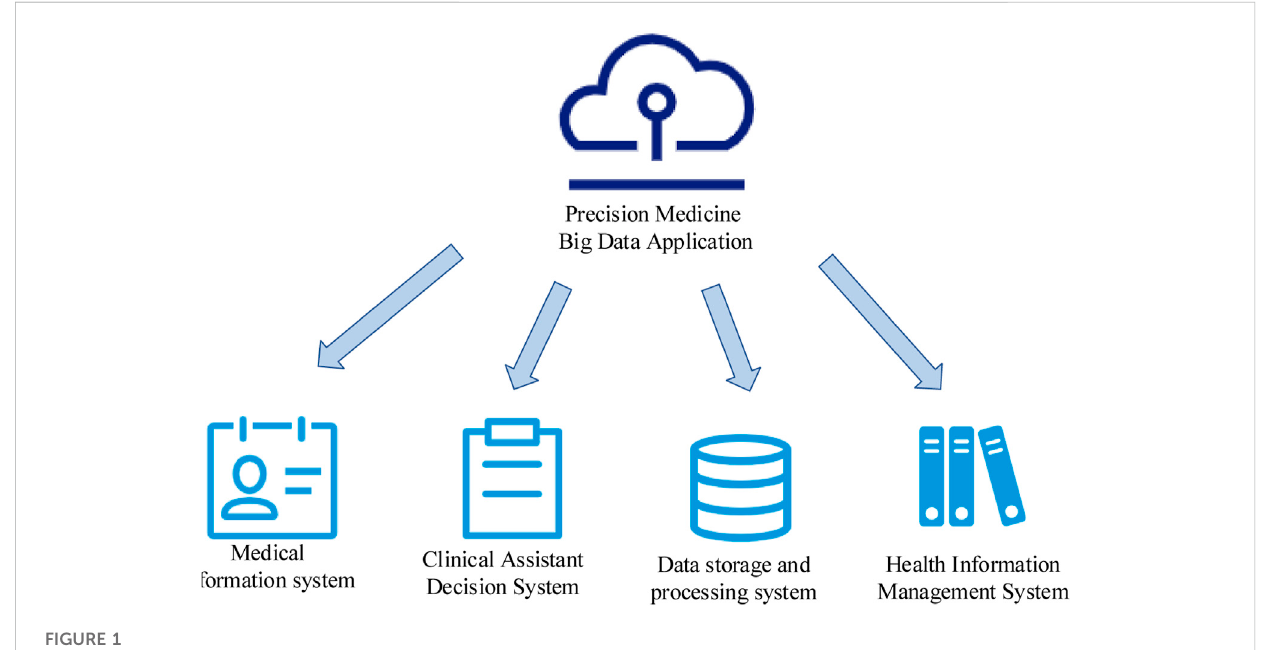
FIGURE 1 Big data applications in precision